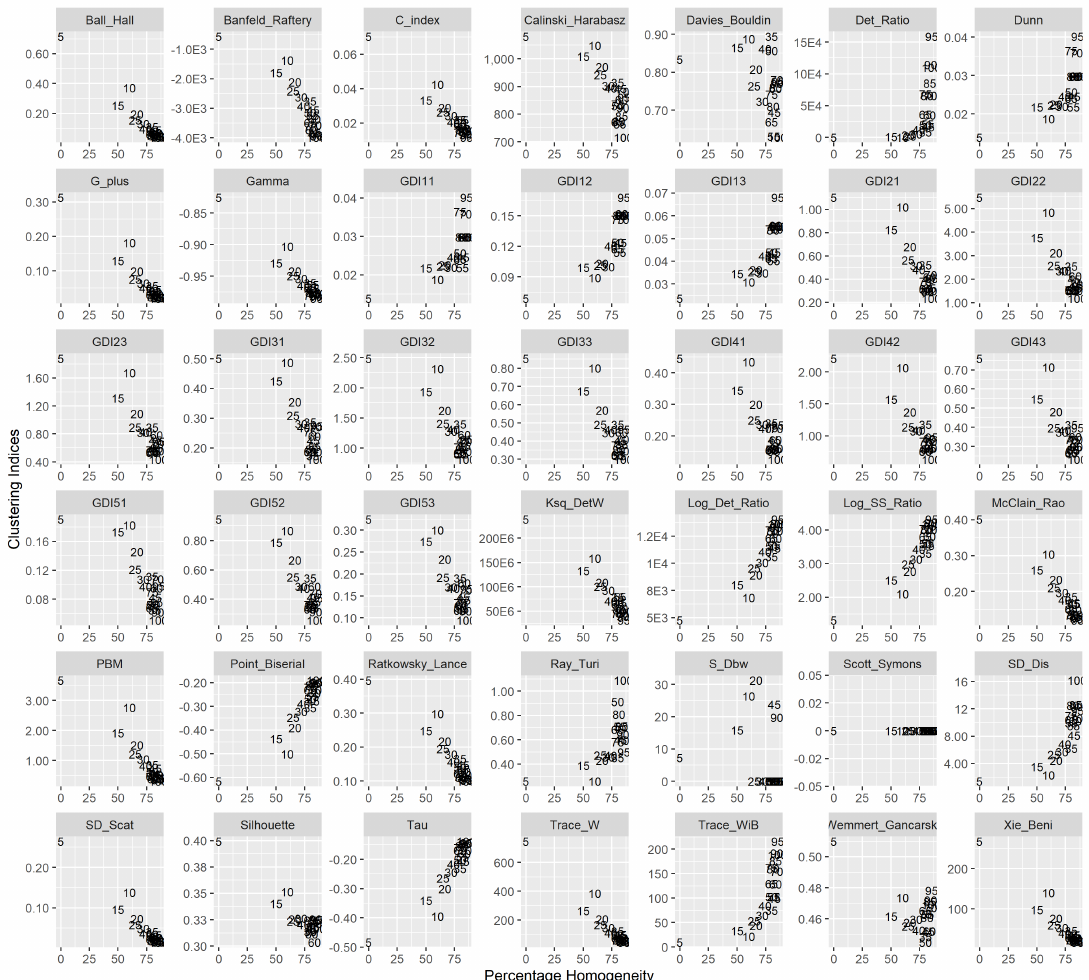
Figure 6. Performance of cluster validity indices in Prairie region—Spring Season. The numbers indicate the percentage homogeneity for the number of clusters in the x-axis and index value on the y-axis. The scientific notation ‘E’ used in labels of y-axis represent ‘10 to the power